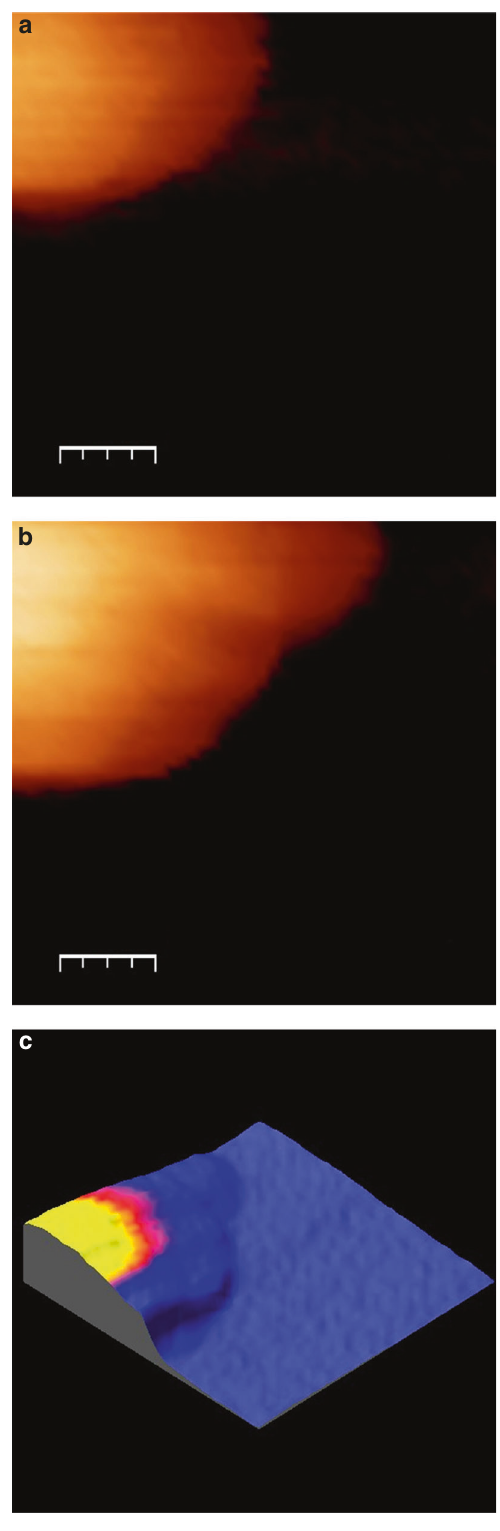
Fig. 5 Growth of a stable Cu nucleus. Initial ( a ) and fi nal ( b ) images of the growth of a stable Cu nucleus on the ITO substrate over 57 s; the scale bars represent 70 nm. Image c corresponds to a colour-scale representation of the initial image ( yellow-pink denotes the dimensions and position of the original nucleus) superimposed on a 3D surface representation of the fi nal image, as seen after 57 s. Supplementary Movie 2 shows the